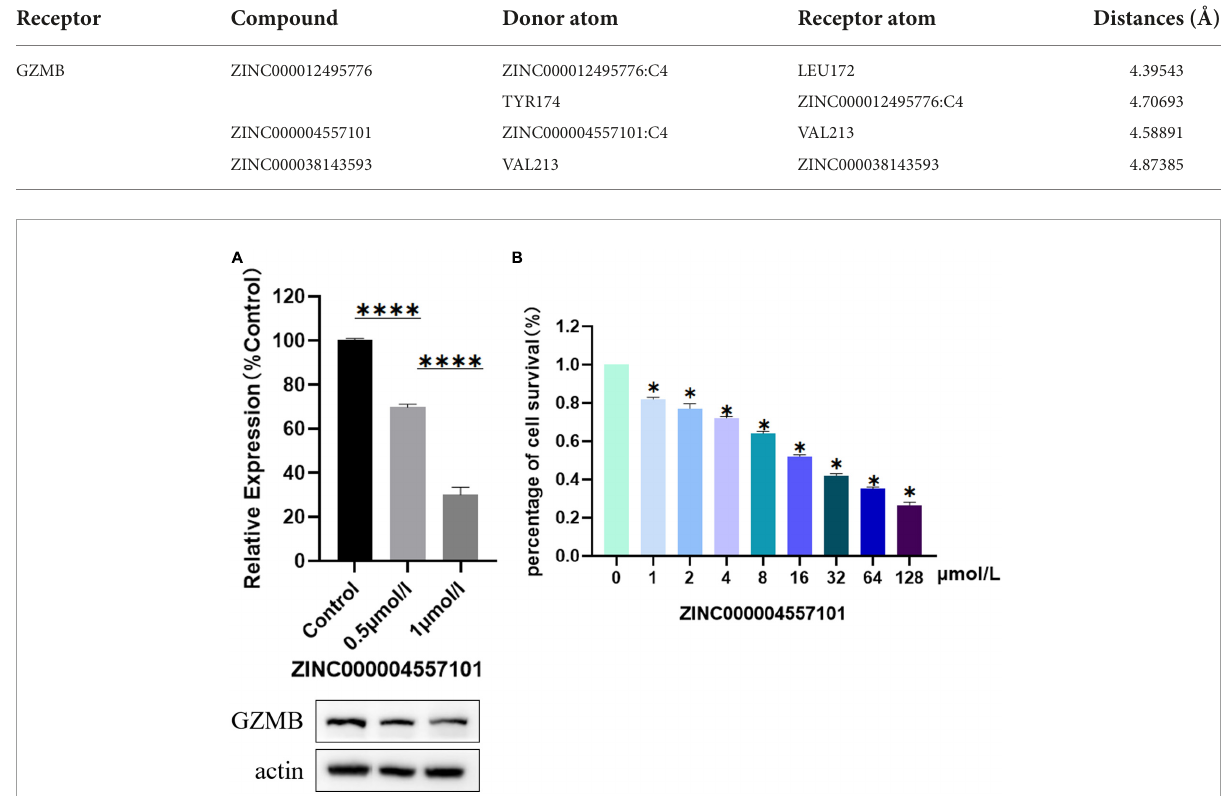
TABLE 7 π -related interaction parameters for each compound with granzyme B. Receptor Compound